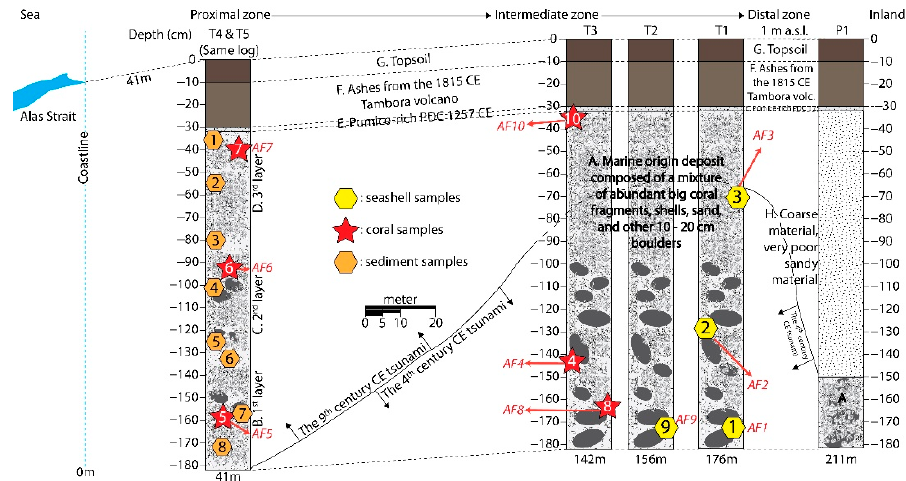
Figure 6. Stratigraphic profiles for all sampling points in abandoned fishponds in Kiantar Village. Table 3. Statistical parameters and textural type percentages from the T4 outcrop (see Figure 6). Sample